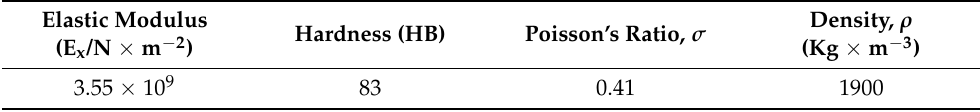
Table 1. Material Parameters of the Epoxy Resin